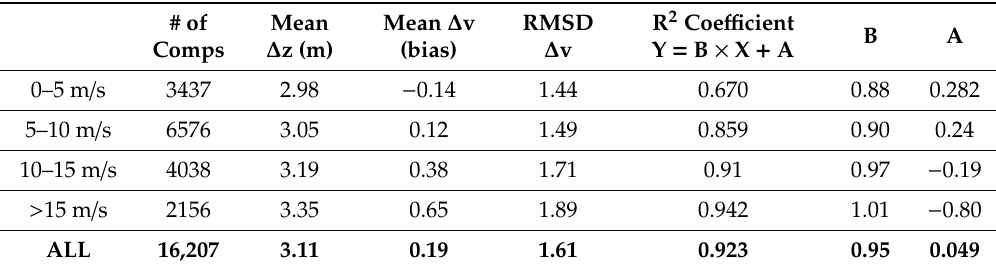
Table 9. DAWN-dropsonde comparison statistics by DAWN wind speed for v component of the horizontal wind.